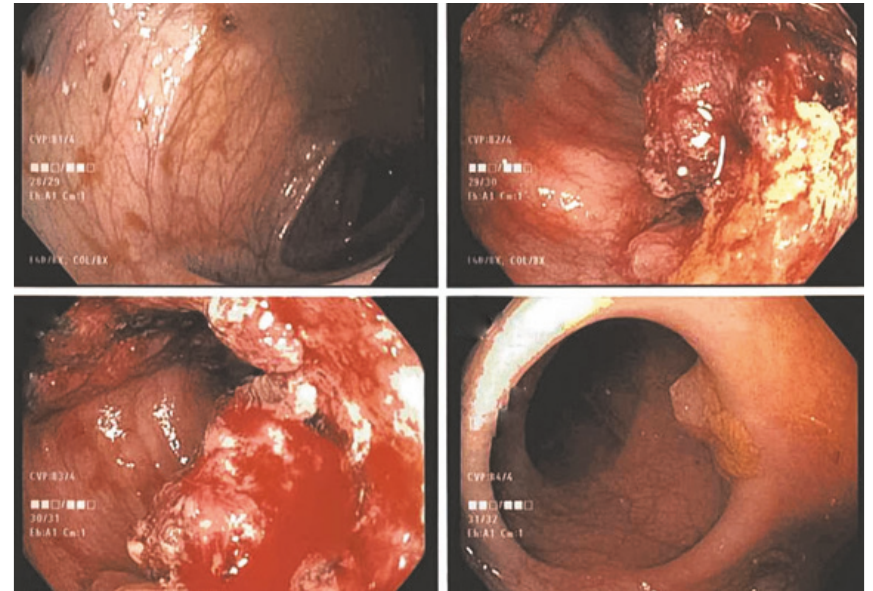
Figure 1: Endoscopic photographs showing normal colonic mucosa (top left), abnormal polypoid mass (toprightand bottom left), and sessile polyp (bottom